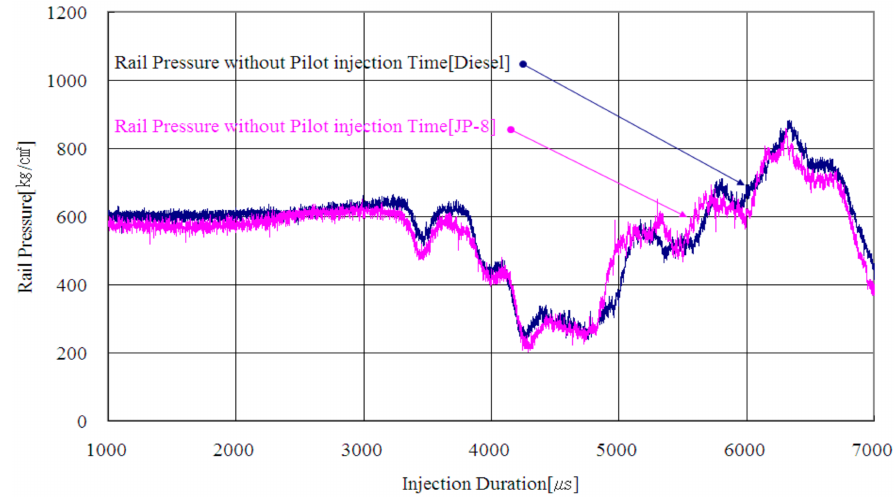
Figure 5. Fuel line pressure between common rail and injector during injections of diesel and JP-8 without pilot